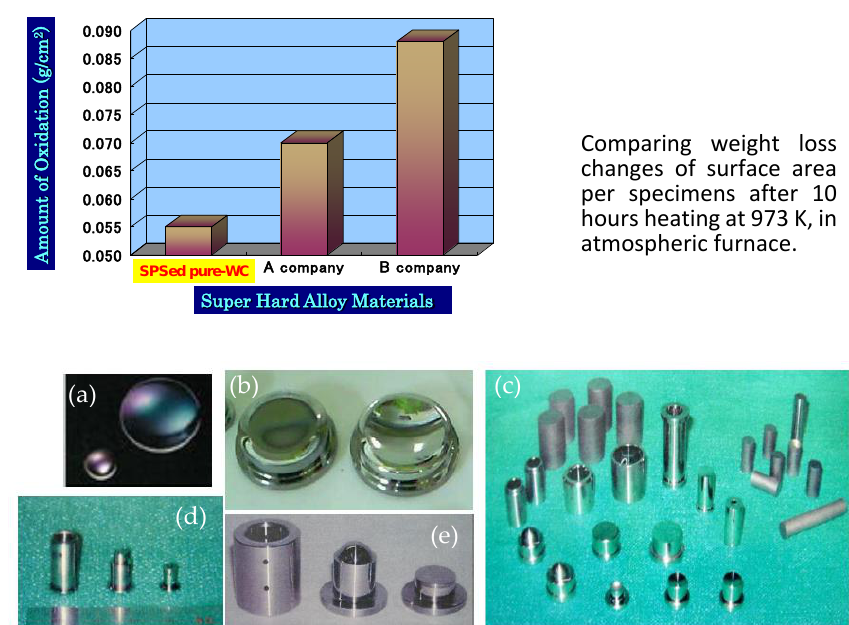
Figure 34. Examples of pure WC Aspheric glass lens mold materials s: ( a ) Formed small and large Aspheric glass lens; ( b ) Large-size aspheric glass lens molding die; ( c ) various SPSed compacts for glass lens die material and finished parts; ( d ) Finished glass lens sleeve die and punches for mobile phone applications; and ( e ) Finished glass lens sleeve die and punches for digital camera applications.